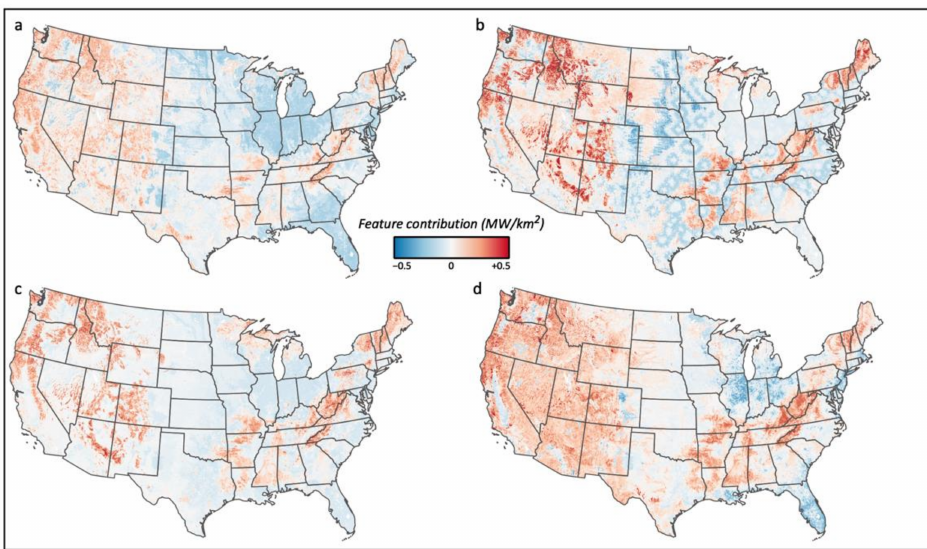
Figure 9. Directional feature contributions (DFCs) explaining the extent to which grid-level (2 km × 2 km) capacity density predictions for CONUS are attributable to the four most influential variables according to a feature importance measure: ( a ) wind energy equitability (WEQ), ( b ) urban accessibility (ACC), ( c ) forest cover (LC4), and ( d ) wind energy (WND). DFCs quantify the contribu- tion of individual variables to each prediction and provide a local interpretation of model behavior. Intuitively, individual predictions are the sum of DFCs for all model variables plus the bias (i.e., mean capacity density value from the training set). DFCs are evaluated at a 2 km × 2 km spatial resolution based on the WIND Toolkit wind resource dataset